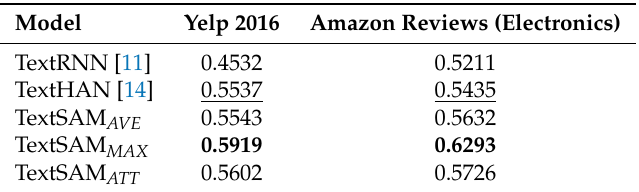
Table 4. Accuracy on the document classification task in the k-fold cross-validation. The results of the best baseline and the best performer in each column are underlined and boldfaced,